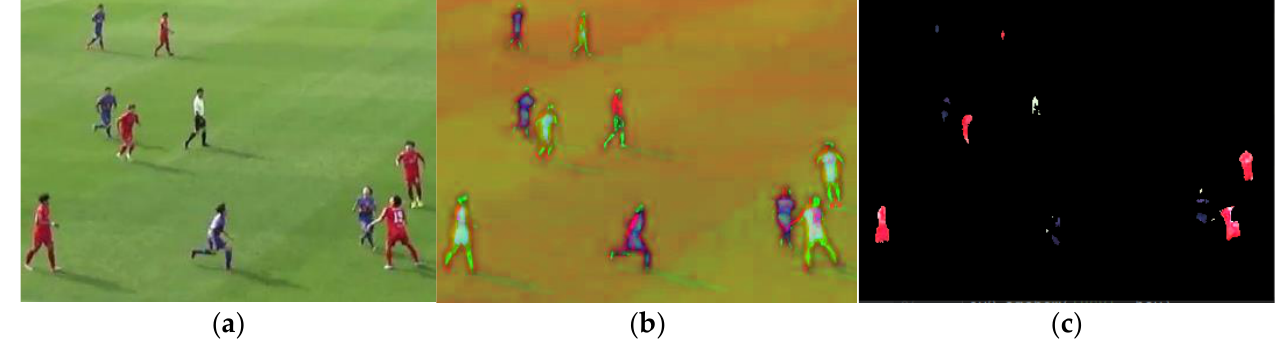
Figure 10. Examples of filtering red, blue, and white colors from an image: ( a ) Original RGB image; ( b ) HSV color conversion image; ( c ) Color filtered image.